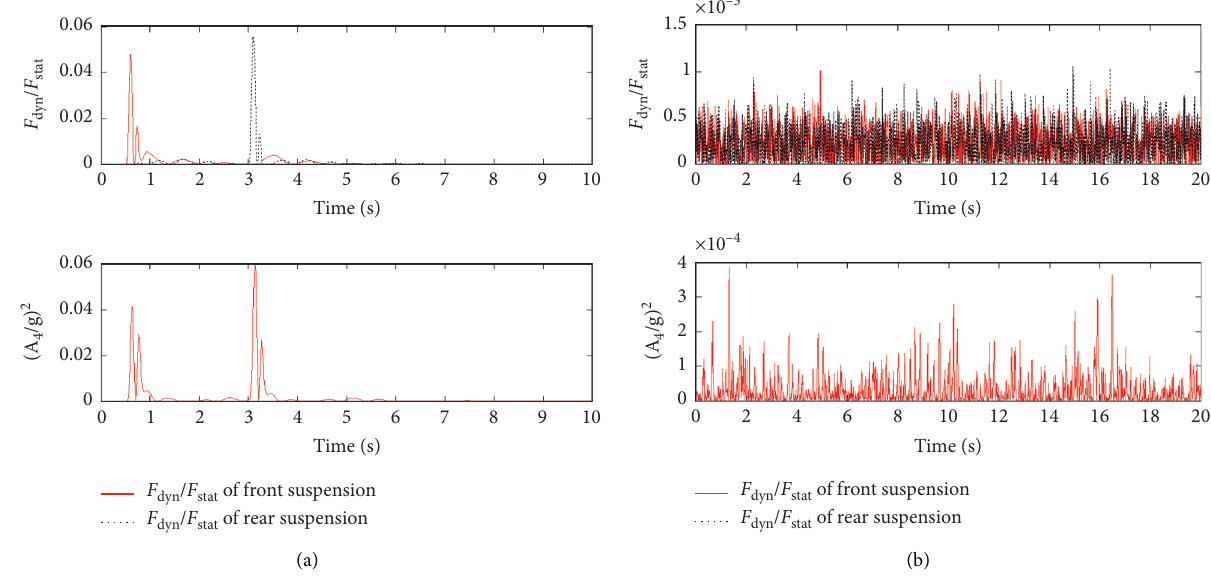
Figure 10: Responses of the ratio of dynamic loads and static loads of the front and rear tire against road inputs and the square of ratio of acceleration and gravity acceleration against the road inputs (a) for bump excitation and (b) for random inputs. The vehicle velocity v � 1.1256m/s (the time delay τ � 2.5 second), the simulation period T � 20 seconds, and sampling interval (h) � 0.01seconds.